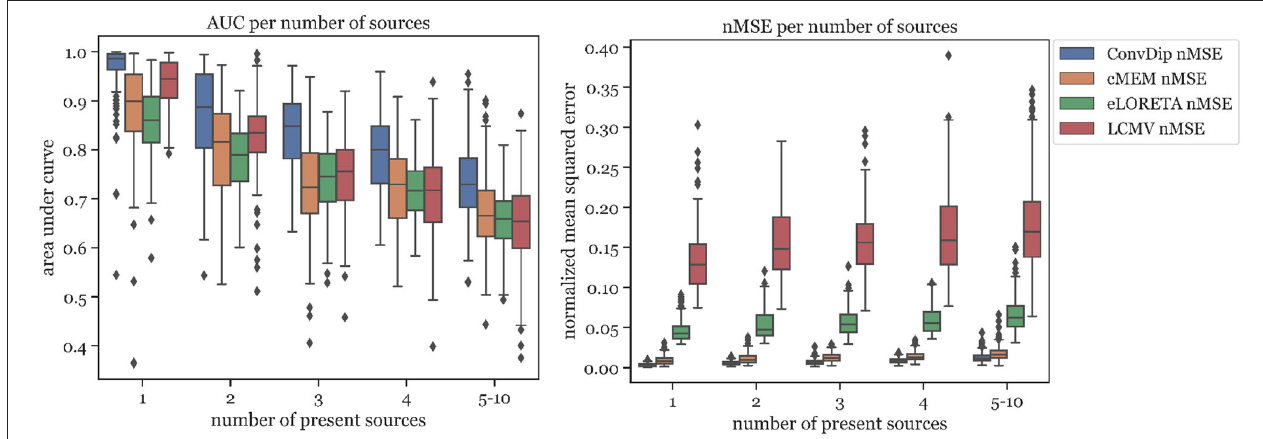
FIGURE 4 | Area under the curve and normalized mean squared error for each inverse algorithm grouped by the number of present source clusters. The right-most columns in each of the graphs display the results for samples containing between 5 and 10 source clusters.